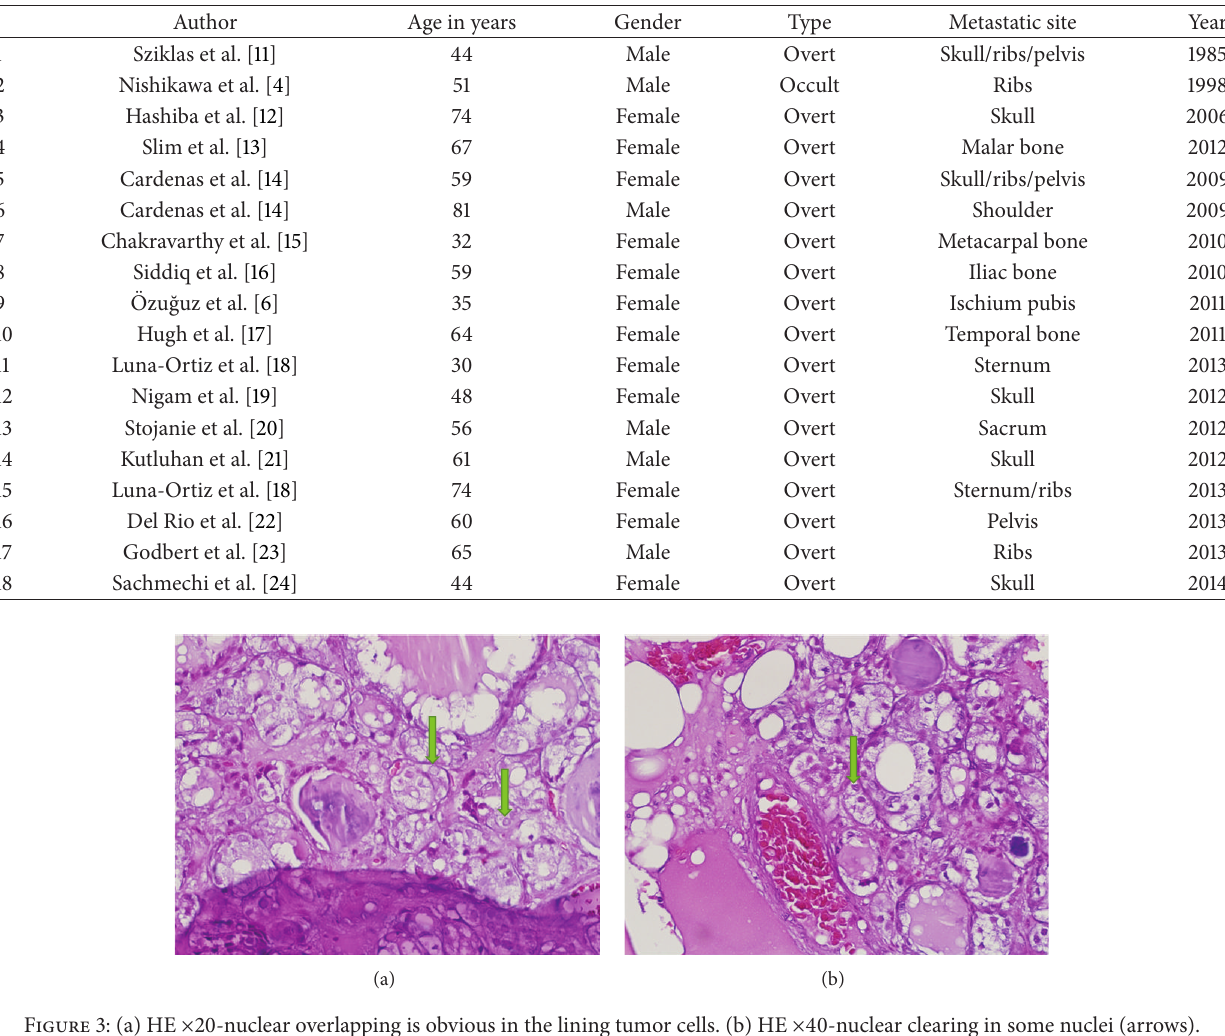
Table 1: Cases of occult and overt papillary thyroid carcinoma metastasis to the bone indicating different metastatic sites.